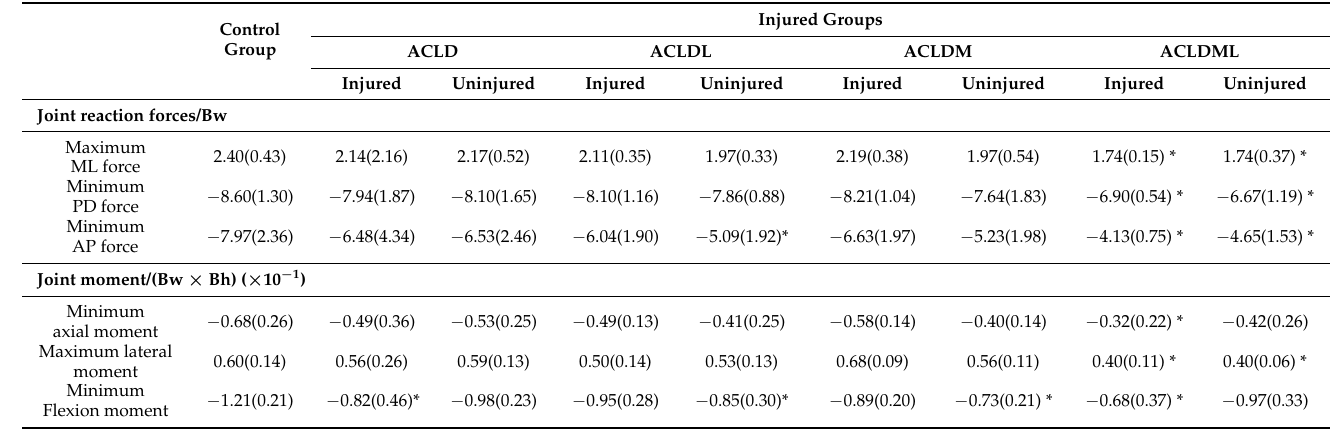
Table 3. Group Means (Standard Deviations) for kinetic parameters in the control limbs, injured and contralateral uninjured limbs during